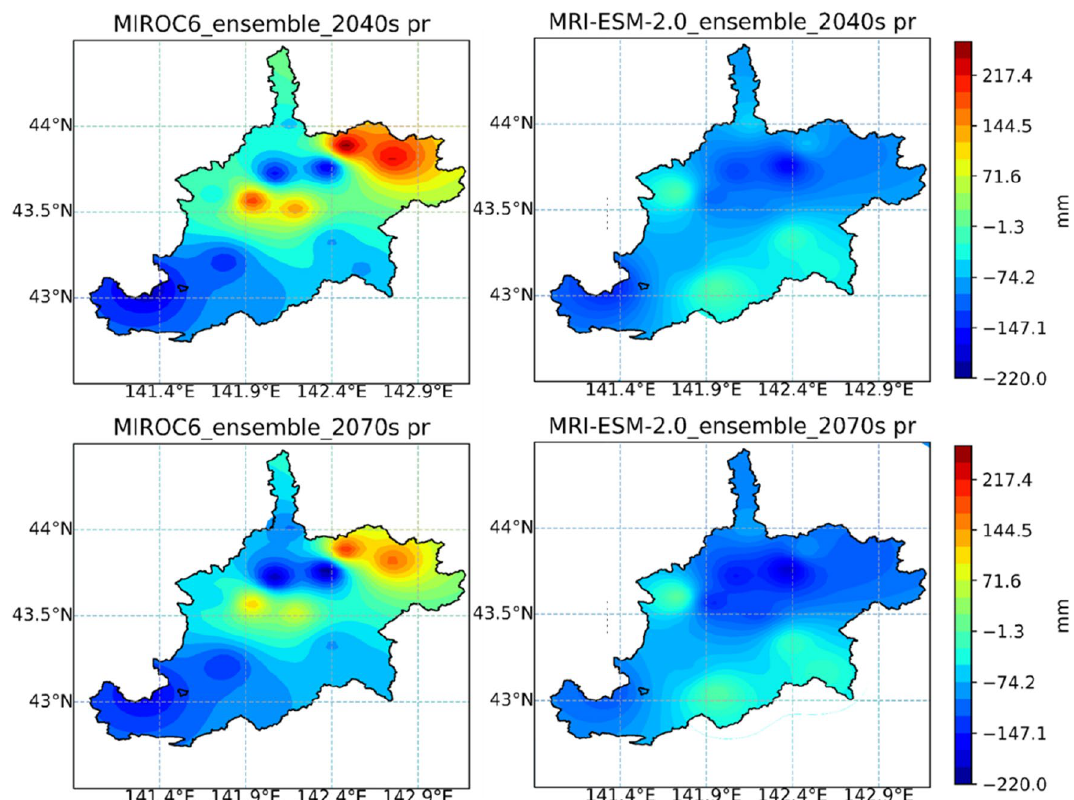
Figure 12. Changes in the annual precipitation (pr) of the Ishikari River basin in periods of the 2040s and 2070s under MIROC6 and MRI-ESM-2.0. Note: Figs. 10, 11 and 12 were generated by Jupyter Notebook (https:// jupyt er. org/) based on Python 3.8.3. Shapefile of Ishikari River basin is download from the Japanese Geographical Survey Institute (JGSI, http:// nlftp. mlit. go.